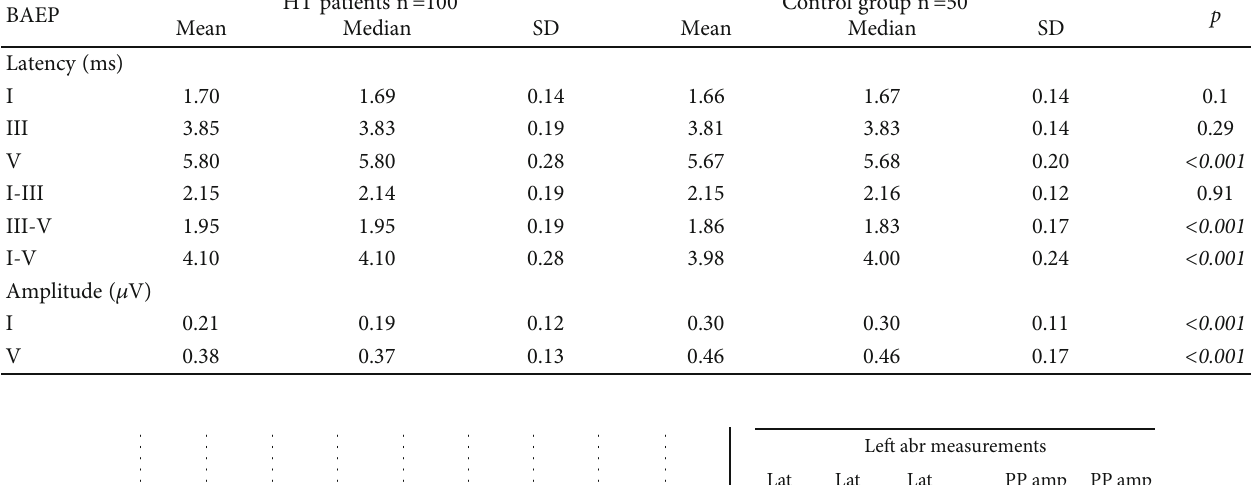
Table 4: Mean values of the latency (ms) and amplitude ( μ V) of BAEP parameters in HT patients and in the control group. BAEP